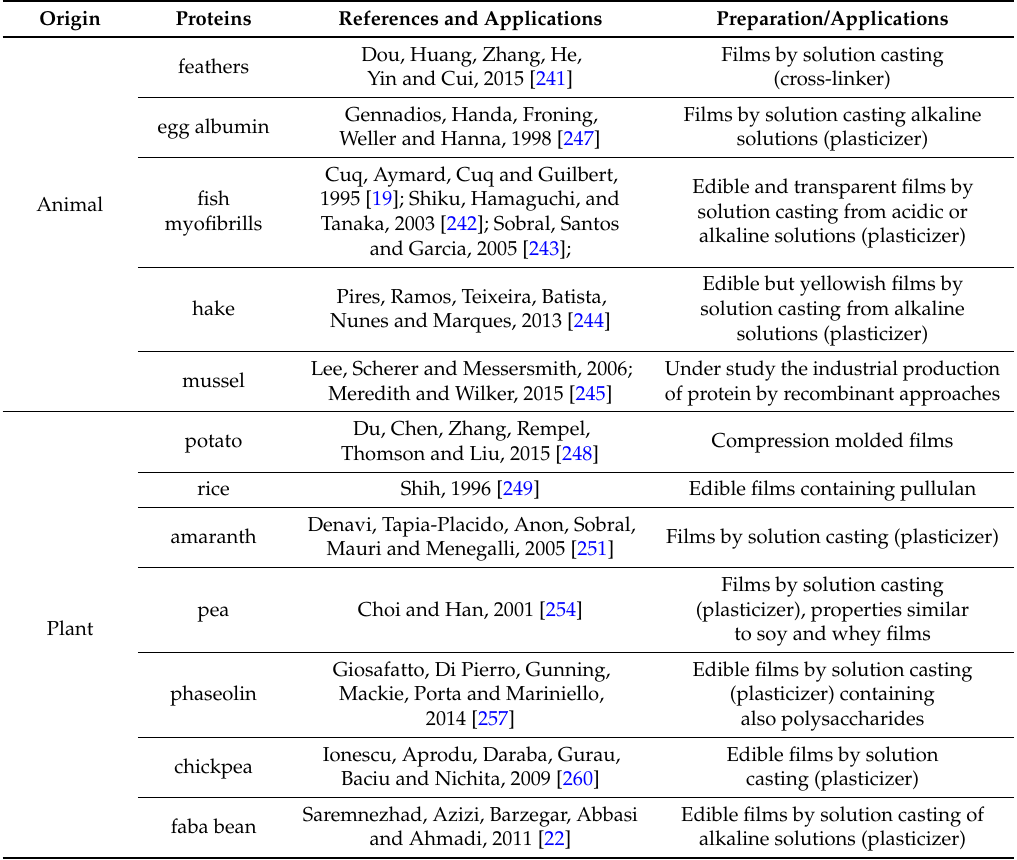
Table 3. Scarcely or recently investigated proteins, references and